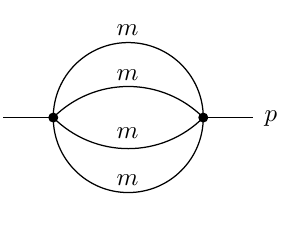
Figure 1 . The three-loop banana